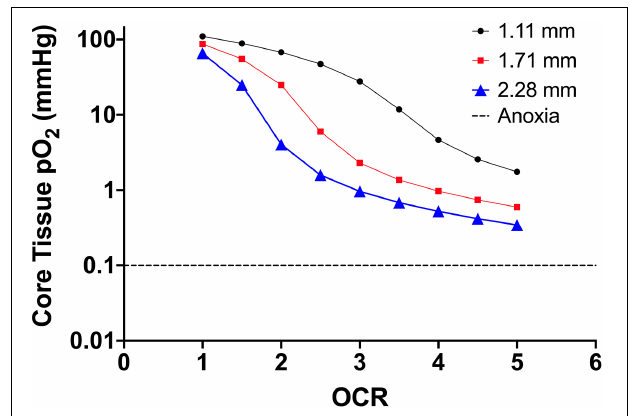
FIGURE 1 | Core tissue oxygen profile of 2D monolayer (20 µ m cell diameter) as a factor of culture media height (three different line plots) and increasing OCR (along the x -axis). The decrease in core pO 2 corresponds to an increase in OCR along the x -axis and the downward shift in core pO 2 is a result of increased media height. The OCR are representative of the published range of most primary endocrine somatic cells and cell lines. The dashed line shows the accepted theoretical cutoff for tissue anoxia and eventual necrotic death in endocrine